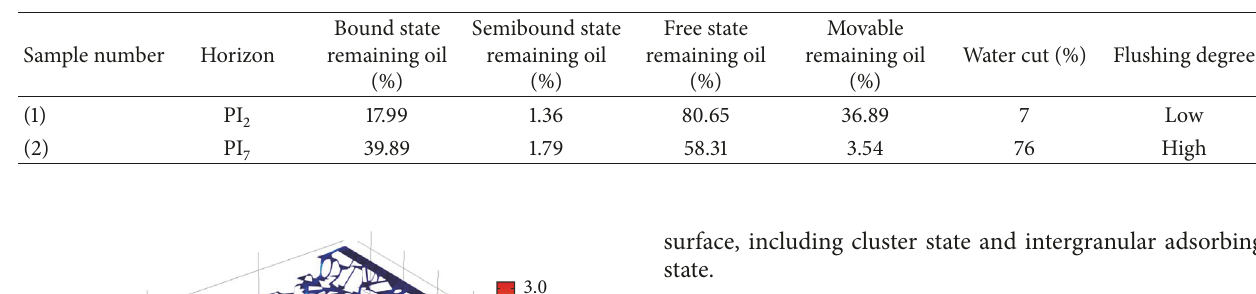
Table 5: The remaining oil distribution and displacement efficiency in different microscopic flow field.